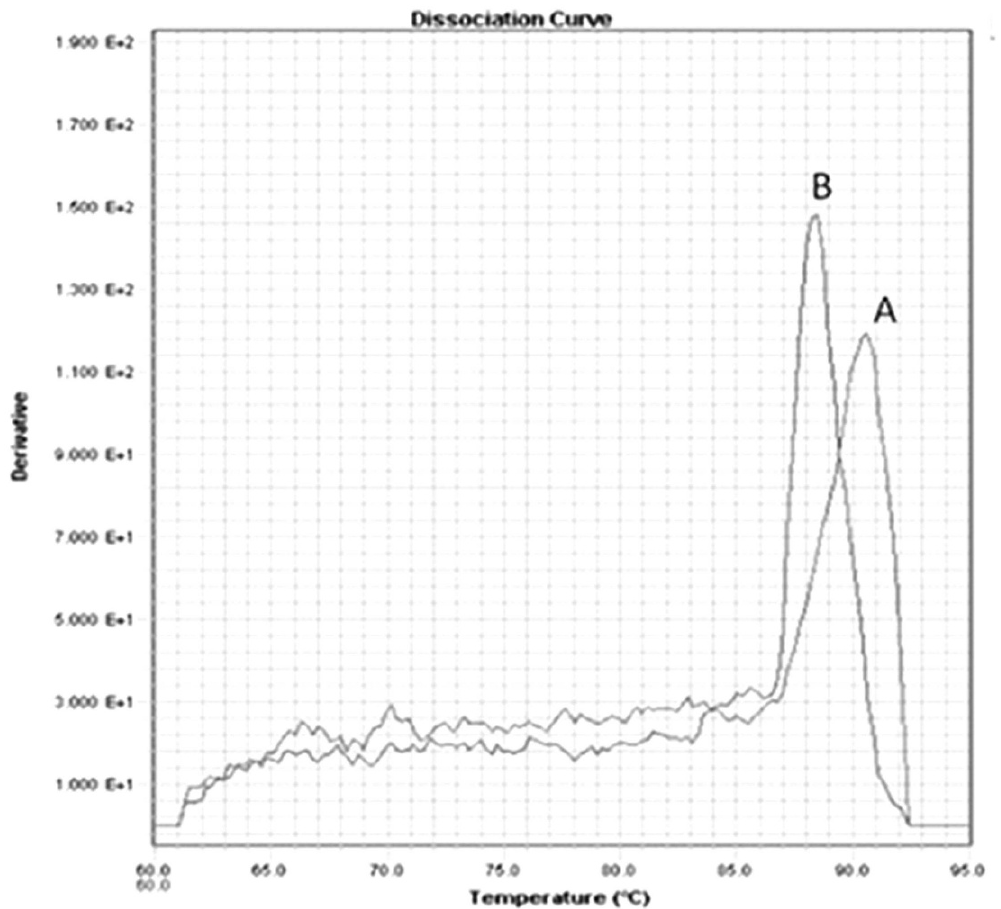
Figure 1 - Melting temperature assay profiles of two subjects: one carrier of HLA B*5701 allele (A) and one non-carrier of the HLA B*5701 allele (B). The two melting profiles are easily distinguishable and allow easy detection of the HLA B*5701